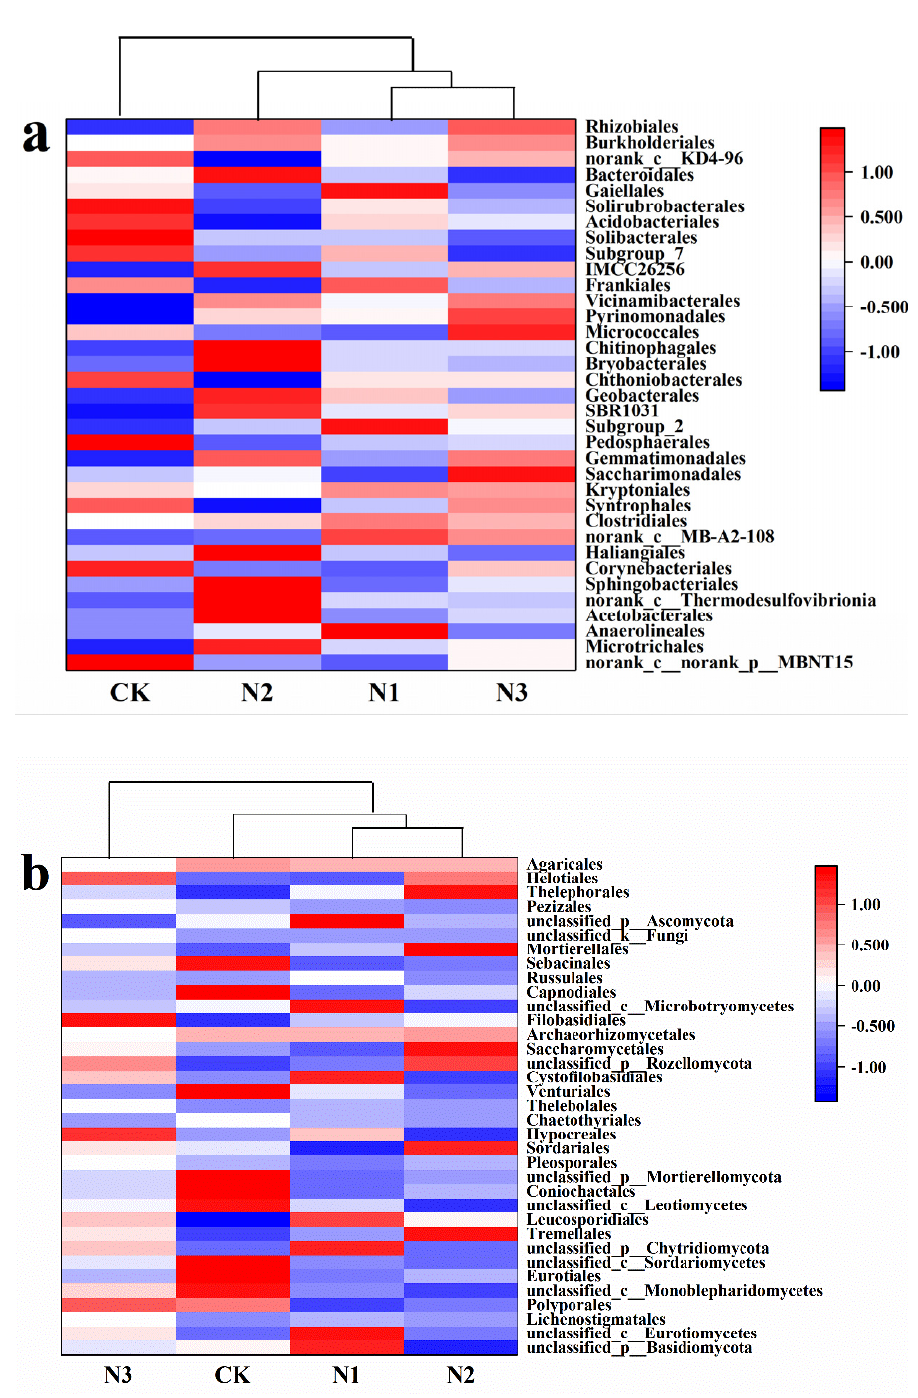
Figure 4. The relative abundances of ( a ) bacteria and ( b ) fungi order with the first 35 most abundant genera were made into a clustering heat map. CK: 0 g N · m − 2 · year − 1 ; N1: 6 g N · m − 2 · year − 1